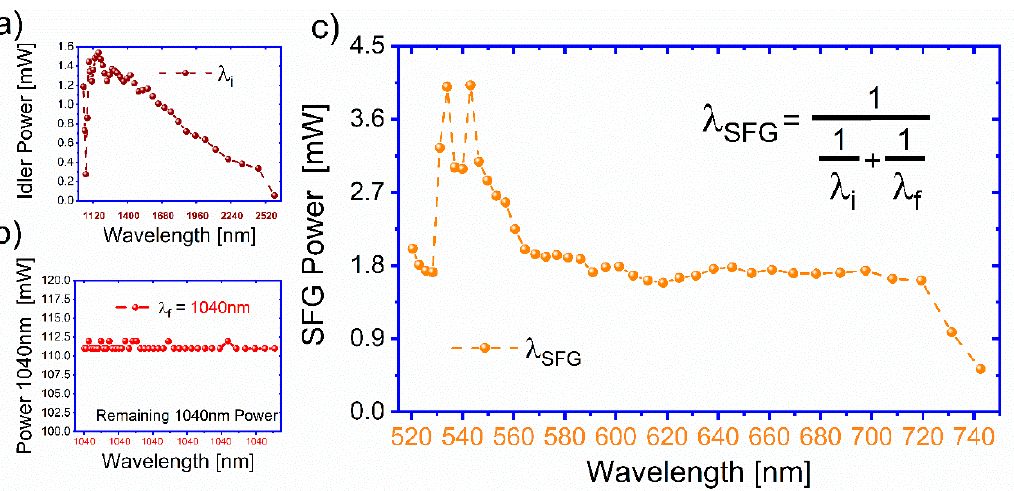
Figure 2. SFG average power using two infrared pump beams. The SFG measurement over a set of wavelengths that employs a noncollinear phase-matching configuration, which is directly pumped from two femtosecond pulses superimposed within a BIBO crystal. ( a ) One pulse is from the tunable range 1042–2600nm (wine line and average power values), ( b ) the second pulse is the remaining 1040 nm light (red line and average power values). ( c ) The resultant SFG as a function of the wavelength range of 520.5 to 742.5 nm. The orange dashed lines are only a guide for the eye.